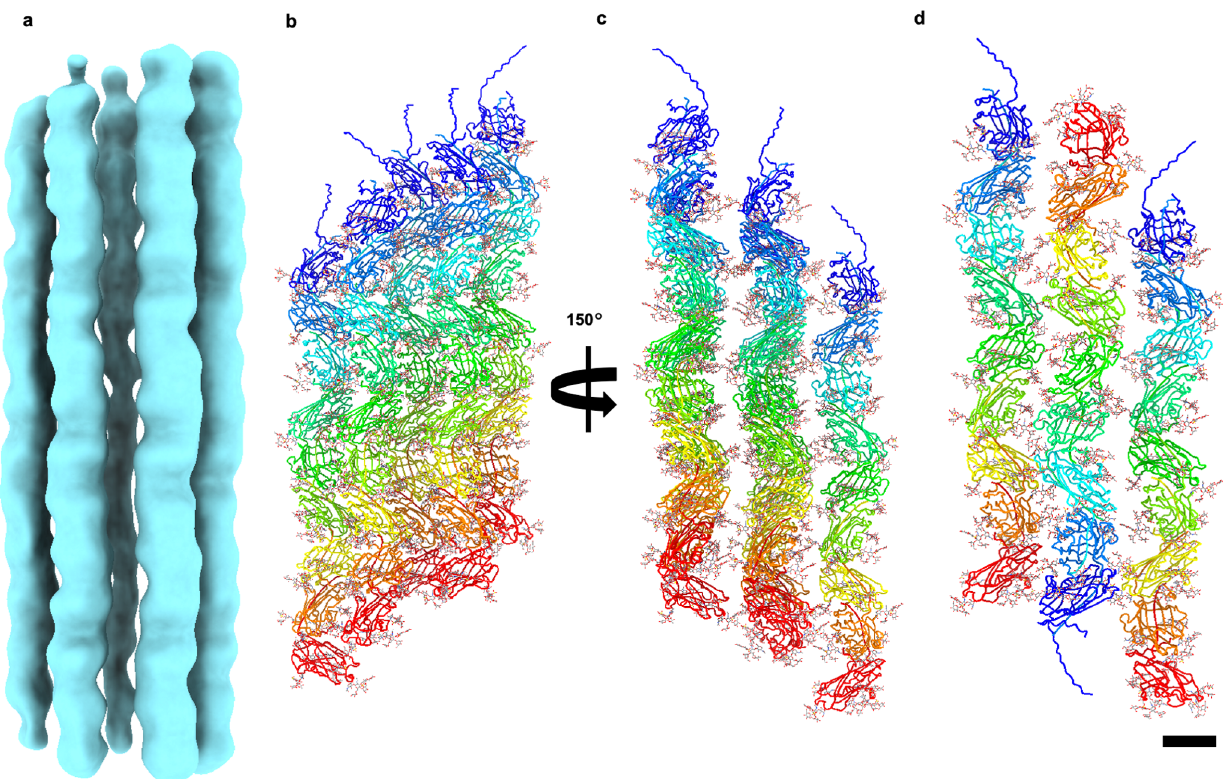
Fig. 2 | Threads form cables of parallel orantiparallel fi laments. a CryoEM map of a thread cable at 13 Å resolution. Atomic models of the thread (in cartoon representation) can be fi tted into the map in parallel ( b , c ) or antiparallel orienta- tion ( d ). Shape complementarity between parallel and antiparallel threads is very